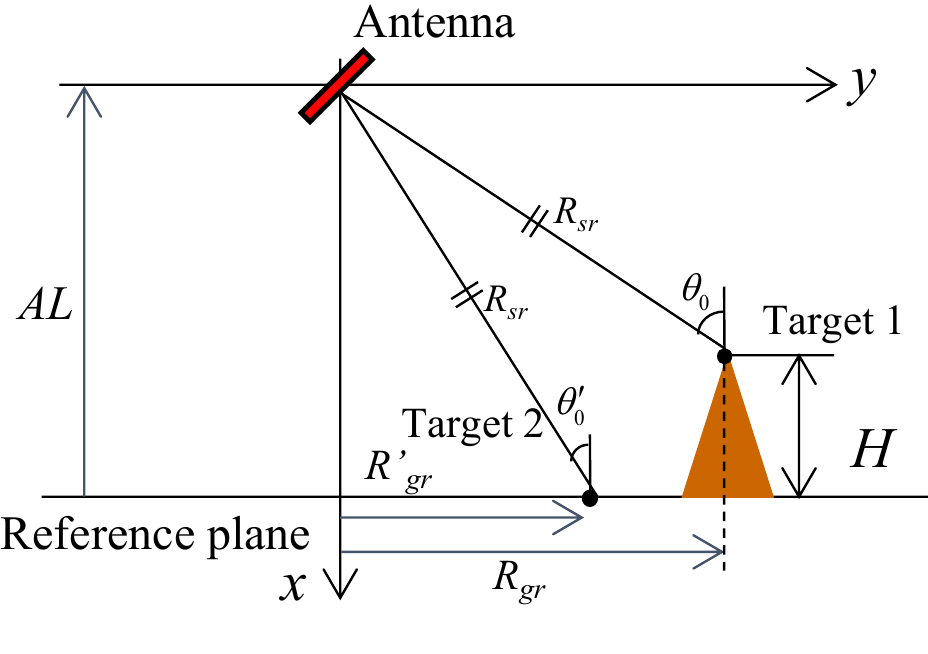
Figure 17. Observation geometric of